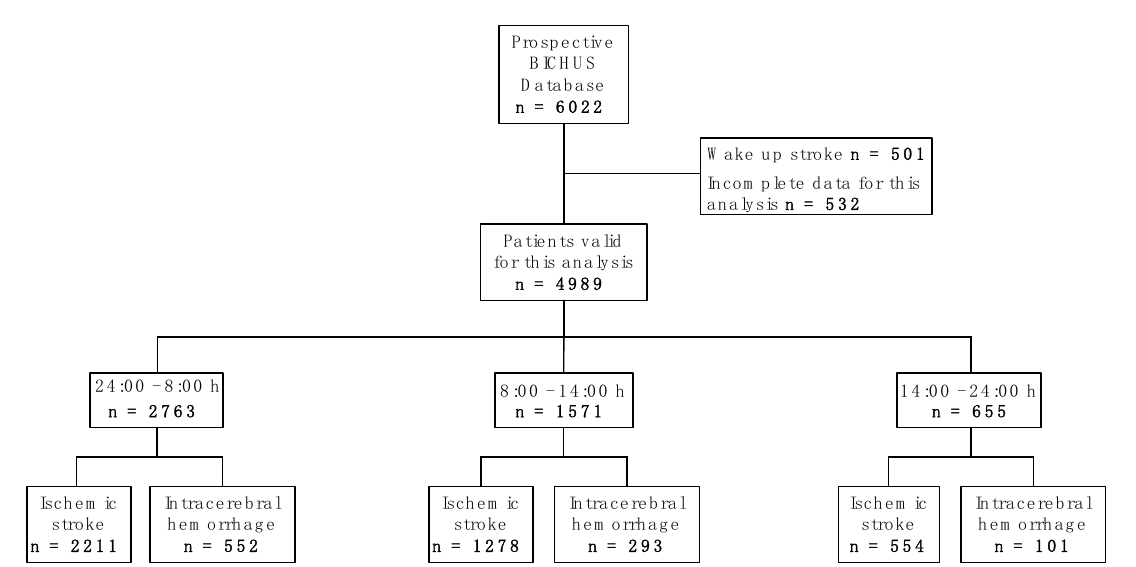
Figure 1. Flowchart of patient screening.